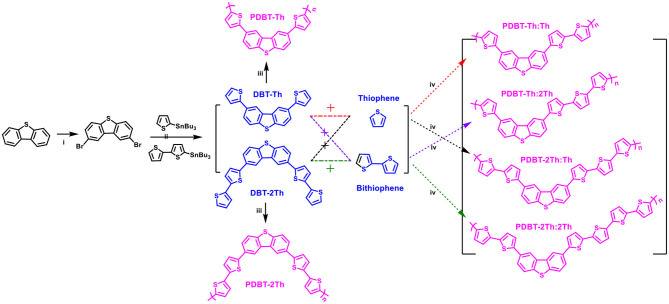
Synthetic routes of monomers (DBT-Th and DBT-2Th) and electrochemical polymers (PDBT-Th, PDBT-2Th, PDBT-Th:Th, PDBT-Th:2Th, PDBT-2Th:Th, and PDBT-2Th:2Th). Reagents and conditions: (i) CHCl3, Br2 (2.2 eq.), N2 (ii) Pd(PPh3)4, chlorobenzene, 90°C, (iii) electrochemical polymerization, CH2Cl2-Bu4NPF6, (iv) electrochemical copolymerization, CH2Cl2-Bu4NPF6.